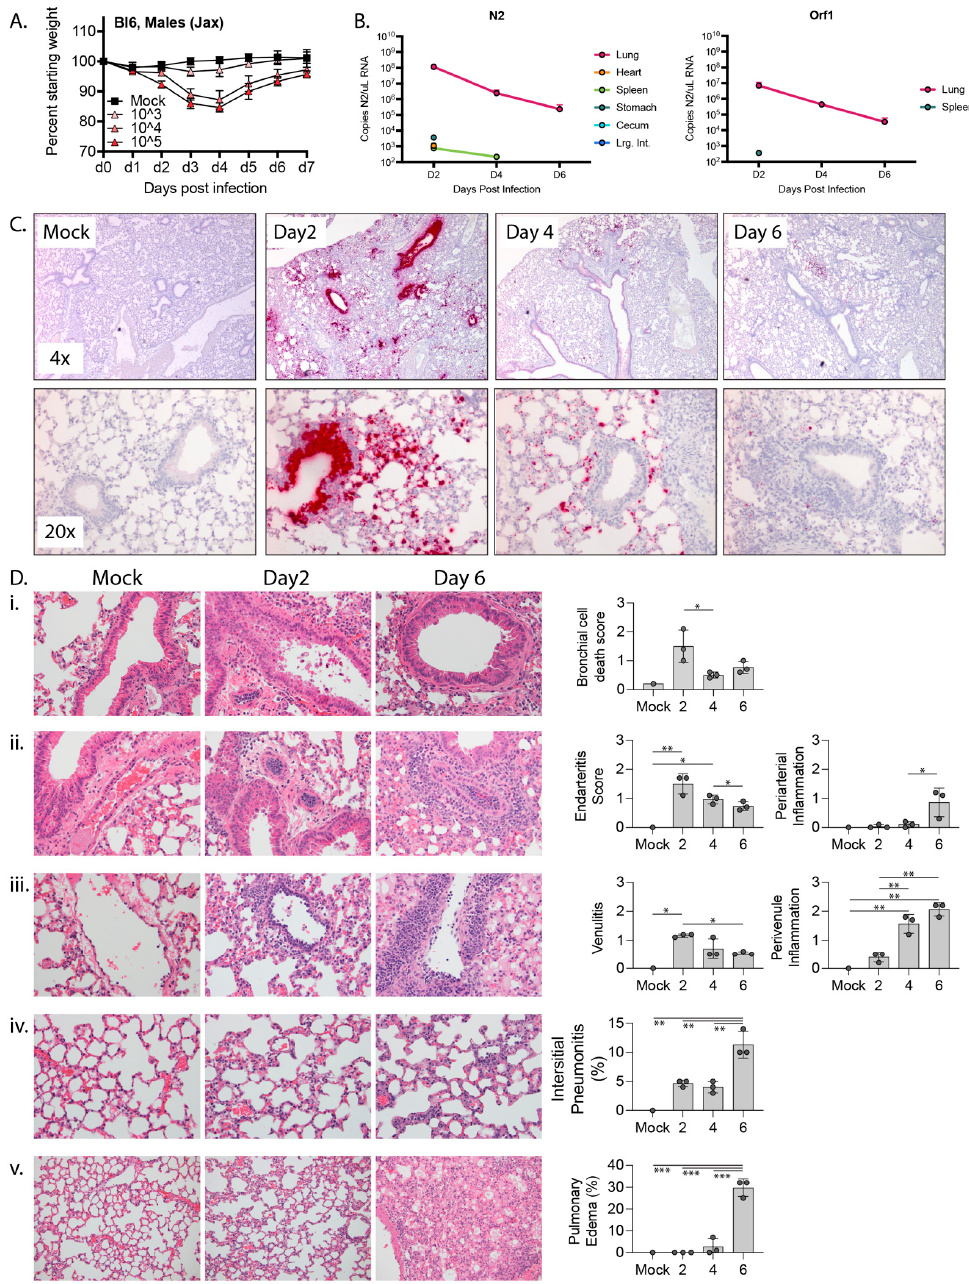
Figure 1. Response to mouse adapted SARS-CoV-2 (MA10) in 10 wk-old C57BL/6 mice. ( A ) 10 wk-old C57BL/6 mice were mock infected or infected with 10 3 , 10 4 , or 10 5 PFU MA10 via intranasal administration and monitored daily for changes in weight, with 5 male mice per cohort. ( B ) Copies of MA10 per µL RNA as determined by qPCR of N2 and ORF1. ( C ) Representative images at 4x (top) or 20× (bottom) of RNA-ISH (in situ hybridization) against the sense strand of Spike (red) from mock infected lungs or lungs collected 2, 4, or 6 days post infection with 10 4 PFU MA10. ( D ) H&E-stained lungs and bar graphs showing (i) bronchiolar epithelial cell death (400 × ), (ii) arterial inflammation (400 × ), (iii) venous inflammation (400 × ), (iv) interstitial pneumonitis (400 × ), and (v) edema (200 × ) from mock infected or MA10-infected lungs collected 2 or 6 days post infection. Significance calculated by one-way ordinary ANOVA using Tukey’s correction for multiple comparisons and reflected by * ( p ≤ 0.05), ** ( p ≤ 0.01), and *** ( p ≤ 0.001). For B-E there were 3 male mice per cohort except for mock which only had one